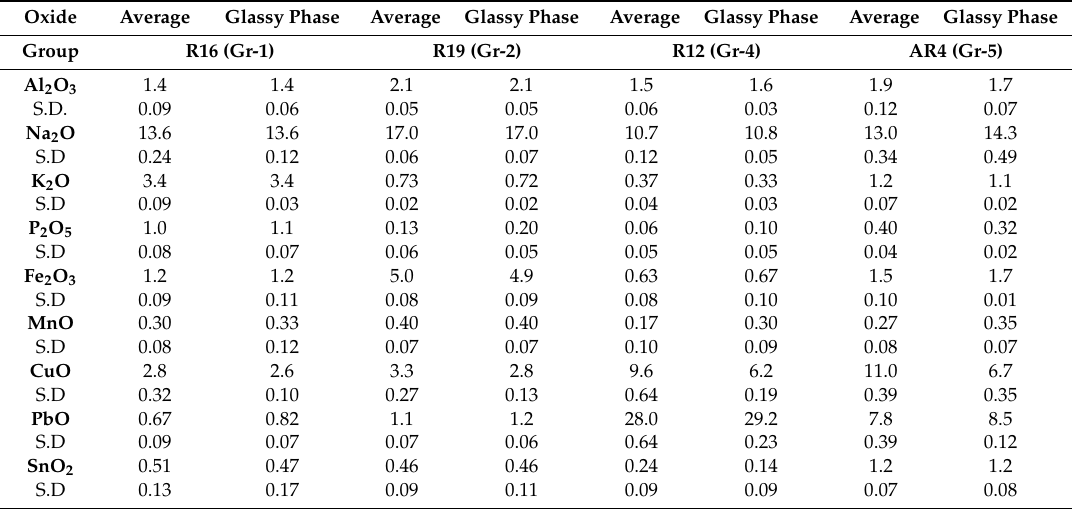
Table 5. Average (crystals + glassy phase) and punctual (glassy phase). EDS analyses performed in the five groups. Two samples coloured by Cu ◦ particles and two samples coloured by Cu 2 O